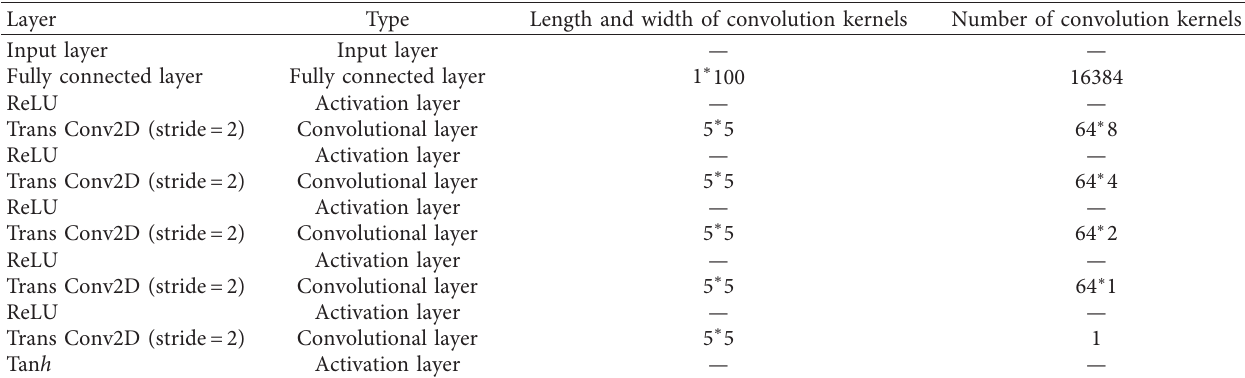
Table 3: Generator structure of the spectrogram GAN